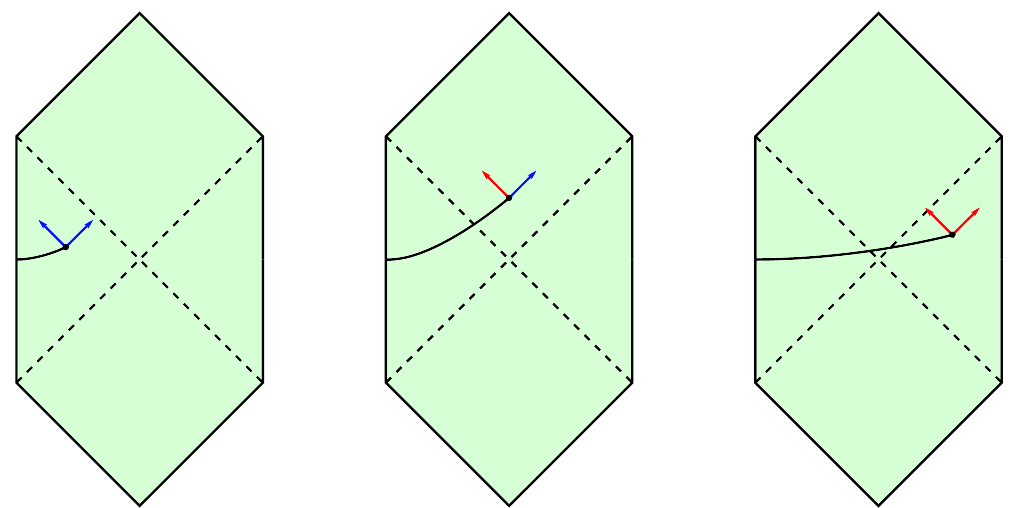
Figure 9 . The H − excitation energy of a particle with left-boundary gravitational dressing, mean- ing the change in H if we create the particle, in the pure JT wormhole solution (3.15). Particles − with positive H are shaded blue, while particles with negative H − have H = 0 . The change of the left-moving excitation energy from positive to negative as we cross + the left future horizon is the essence of the firewall typicality arguments of [35,